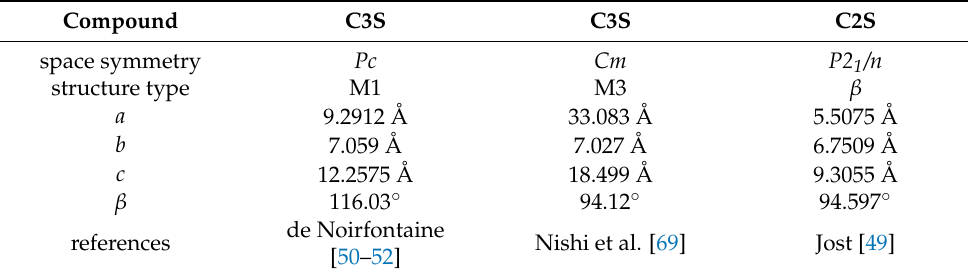
Table 3. Comparison of two monoclinic crystal structures of Ca 3 SiO 5 with the structure of β -C2S. Compound C3S space